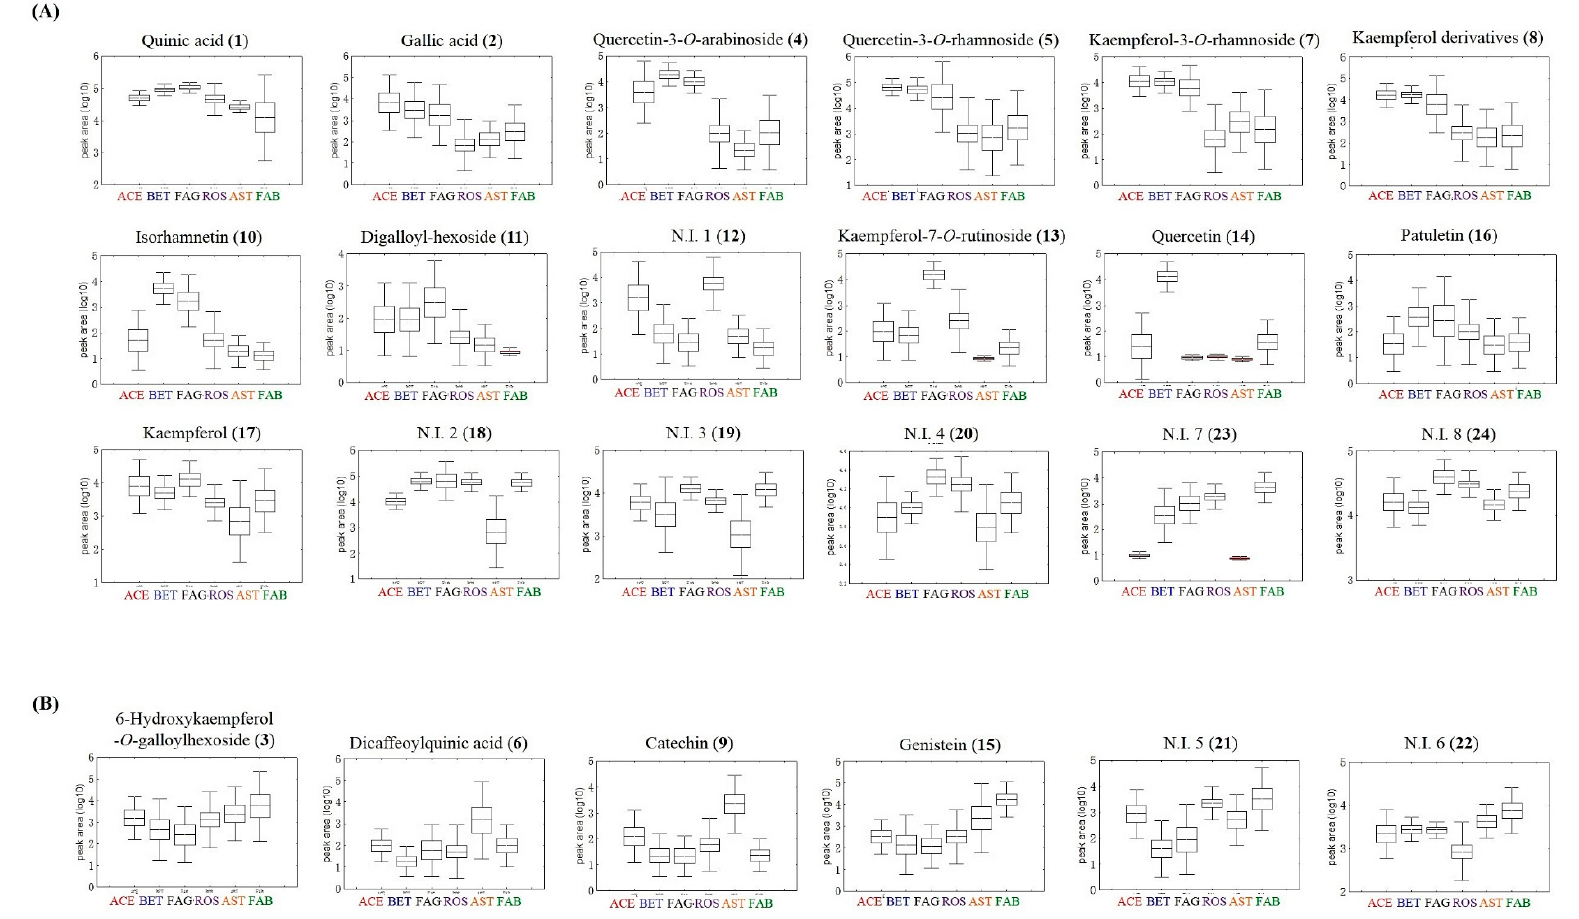
Figure 2. Box and whisker plots of significantly different metabolites among 6 plant families analyzed by ultrahigh performance liquid chromatography (UHPLC)-linear trap quadrupole-ion trap (LTQ-IT) mass spectrometry/mass spectrometry (MS/MS). Metabolites at higher concentrations in Aceraceae, Betulaceae, and Fagaceae ( A ) and at higher concentrations in Rosaceae, Asteraceae, and Fabaceae ( B ) are shown. The Y -axis of the box and whisker plots indicates the peak area of each metabolite transformed by log 10 (ACE, Aceraceae; BET, Betulaceae; FAG, Fagaceae; ROS, Rosaceae; AST, Asteraceae; FAB, Fabaceae; Line , mean; box , standard error; whisker , standard deviation).